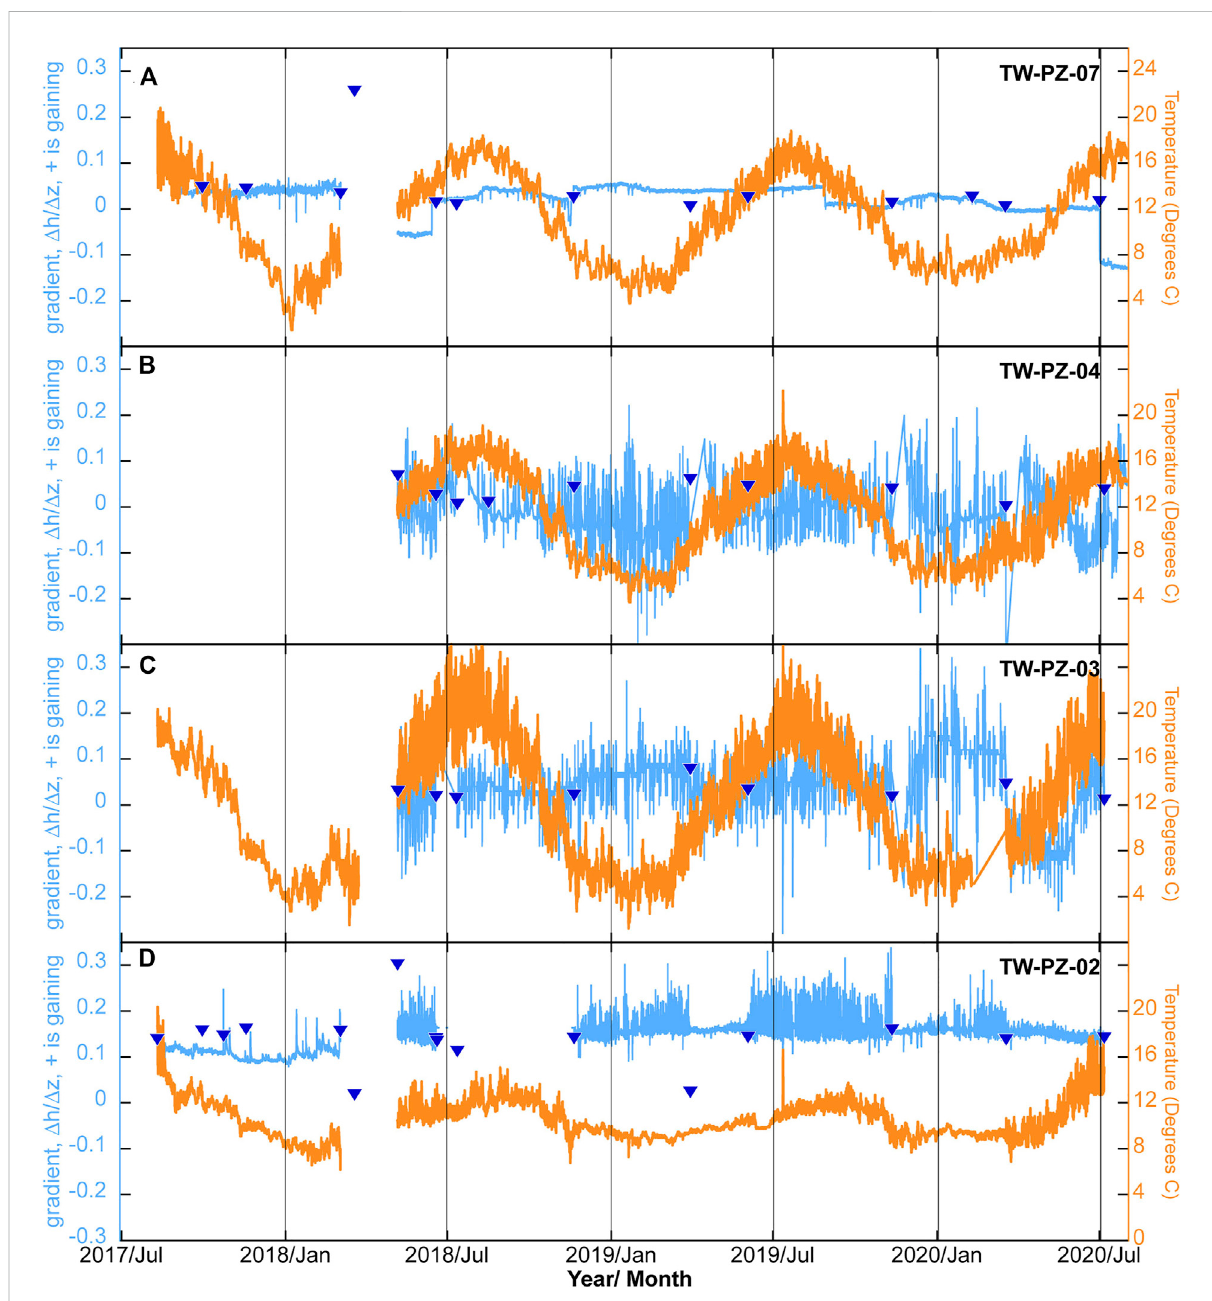
FIGURE 7 Foothills Preserve streambed hydraulic gradients, ( Δ h/ Δ z , blue; symbols = measured) and stream temperatures ( ° C, orange). Positive gradients indicate gaining, or upwelling conditions, and negative values are losing. From upstream to downstream: (A) TW-PZ-07, (B) TW-PZ-04, (C) TW-PZ- 03, and (D)